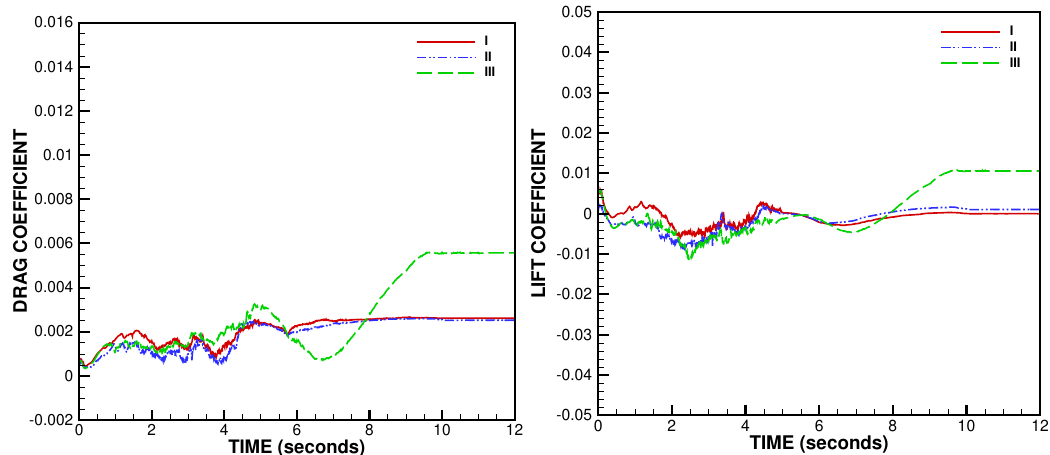
Figure 13. NLG: time history of drag and lift coefficients for the downwind rear